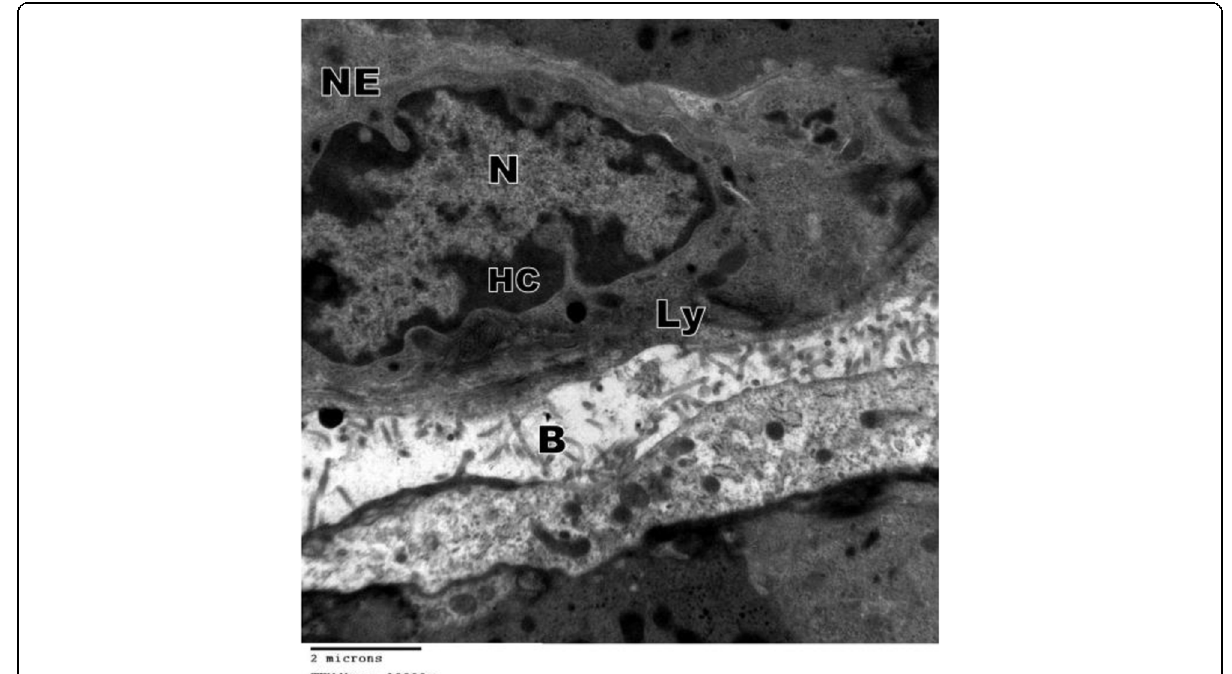
Fig. 25 An electron micrograph of a Kupffer cell of treated mouse with Adamine (20 mg/kg b.wt.) for 15 days showing lysosomes (Ly), nucleus with irregular nuclear envelope (NE), and dense heterochromatin (HC) attached to the inner membrane of nuclear envelope and bile canaliculi (B) is also seen. (×